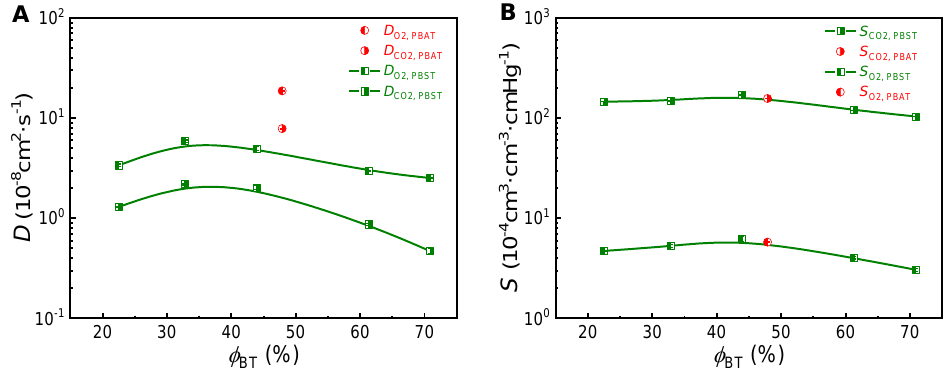
Figure 5. ( A ) Diffusion coefficient ( D O2 , D CO2 ) and ( B ) Solubility ( S O2 , S CO2 ) of PBST and PBAT.